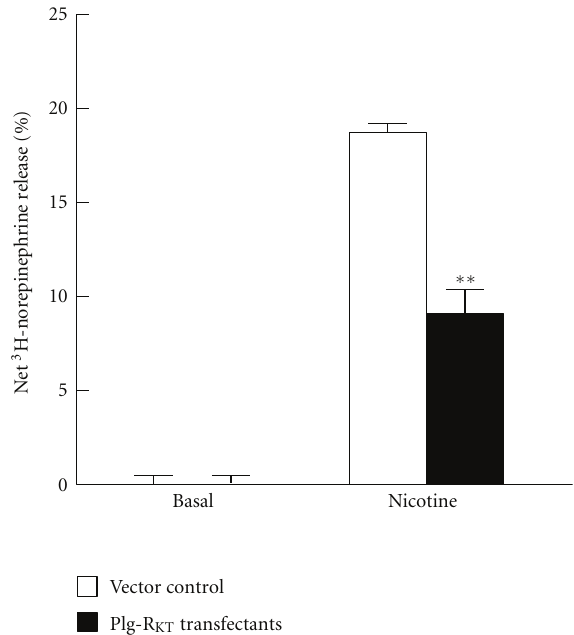
Figure 11: E ff ect of overexpression of Plg-R KT on catecholamine release. PC12 cells stably overexpressing either Plg-R KT (filled bars) or vector alone (open bars) were treated with 60 μ M nicotine (Nicotine) or bu ff er (Basal) at 37 ◦ C for 15 minutes and cate- cholamine release was measured by liquid scintillation counting. Percent release was calculated as percentage of secretion [amount released/(amount released +amount in cell lysate)] and results expressed as net release (% secretagogue-stimulated release minus % basal release). Results are represented as mean ± SEM, n = 9 for each experimental group. ∗∗ P < 0 . 001 for the Plg-R KT transfectants stimulated with nicotine compared with corresponding values for the vector control cells. [25]. ©The American Society for Biochemistry and Molecular